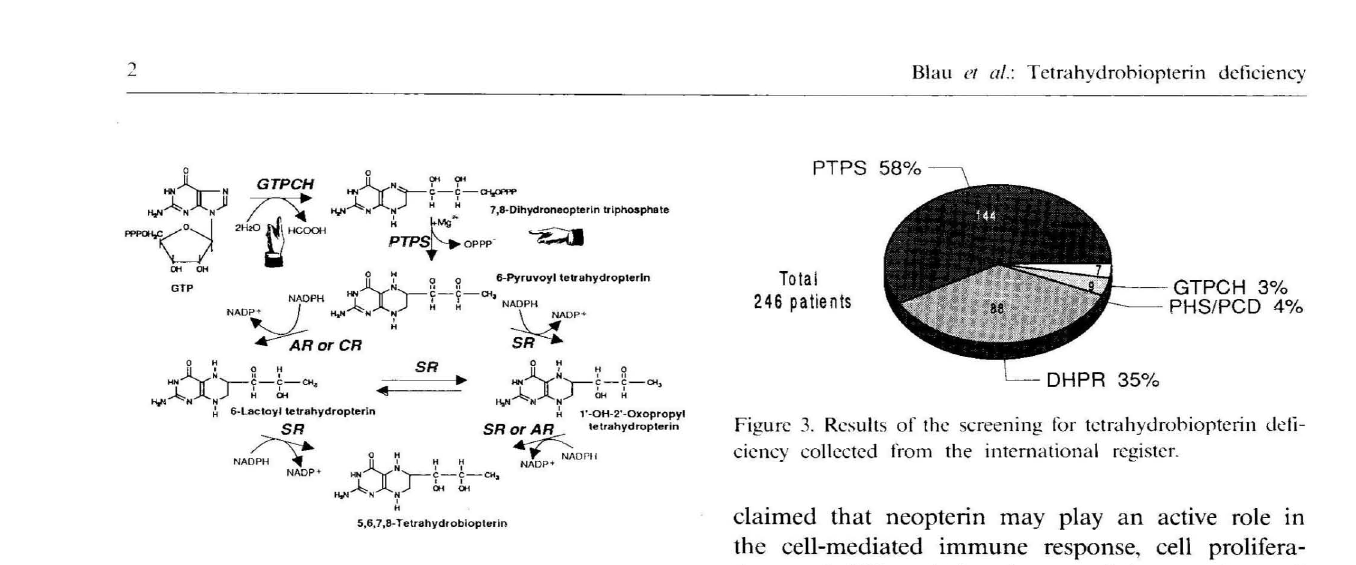
Figure 3. Results of the screening for tetrahydrohiopterin dcti ciency collected from the international